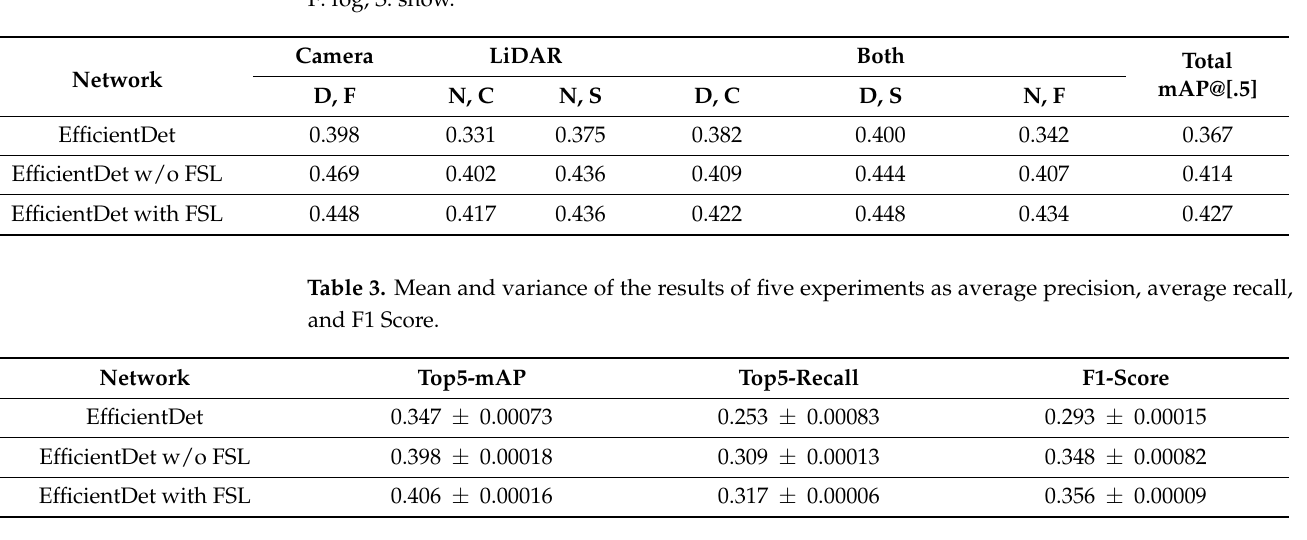
Table 2. Performance according to weather and performance comparison with other networks. The best performance index among the results of five experiments. D: daytime, N: nighttime, C: clear, F: fog, S: snow.